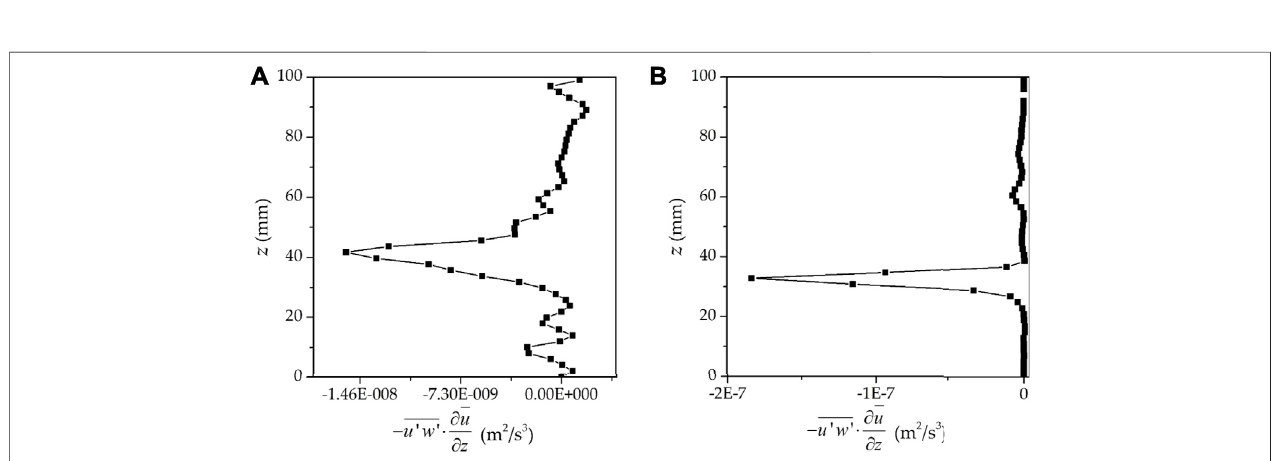
FIGURE 8 | Vertical pro fi les of the shear term of the TKE equation under different experimental conditions: (A) case 7 and (B) case 12, respectively.